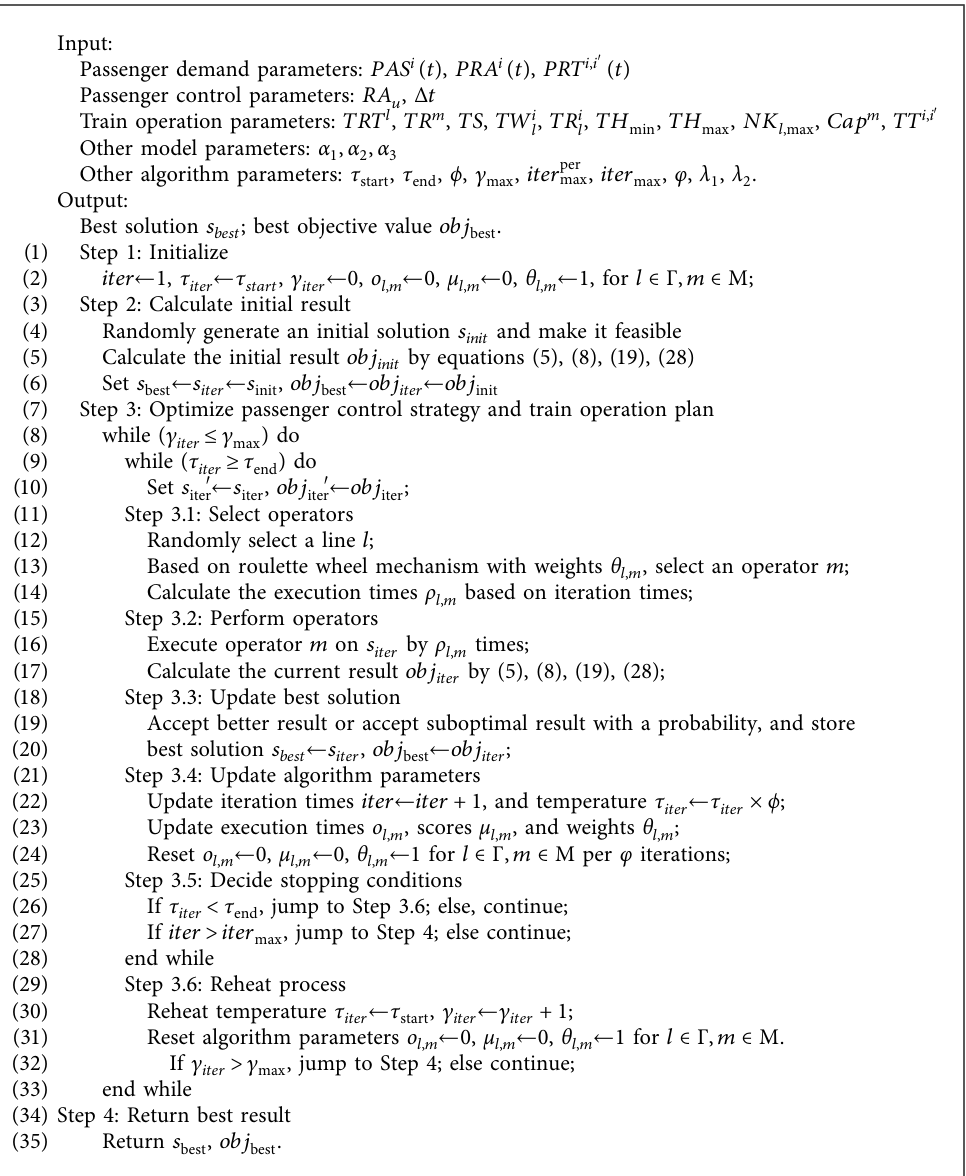
A LGORITHM 1: MOSA